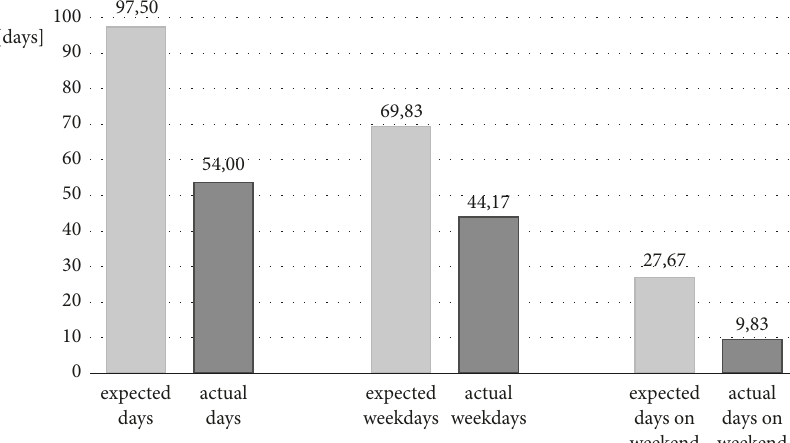
Figure 5: Descriptive analysis of expected and actual days worn in relation to all days, weekdays, and the weekends for